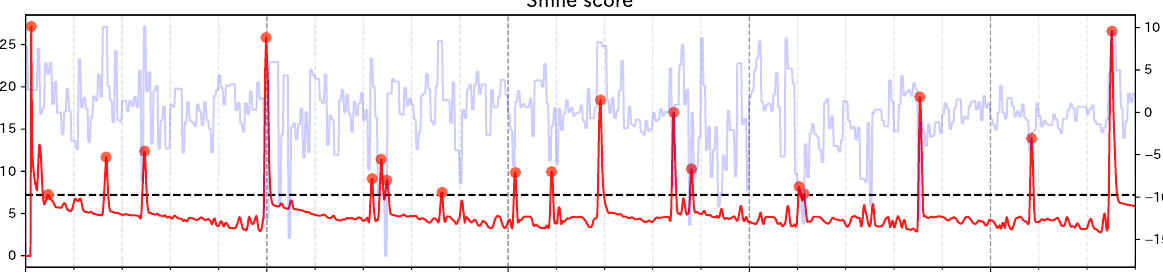
Figure 12. Graph of the change score for the Smile scale (Subject